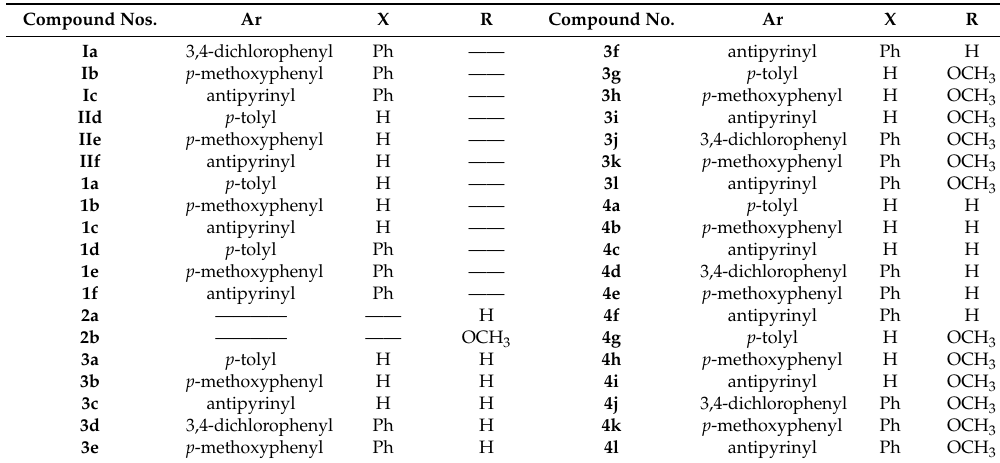
Table 1. List of all synthesized compounds shown in Scheme 1.